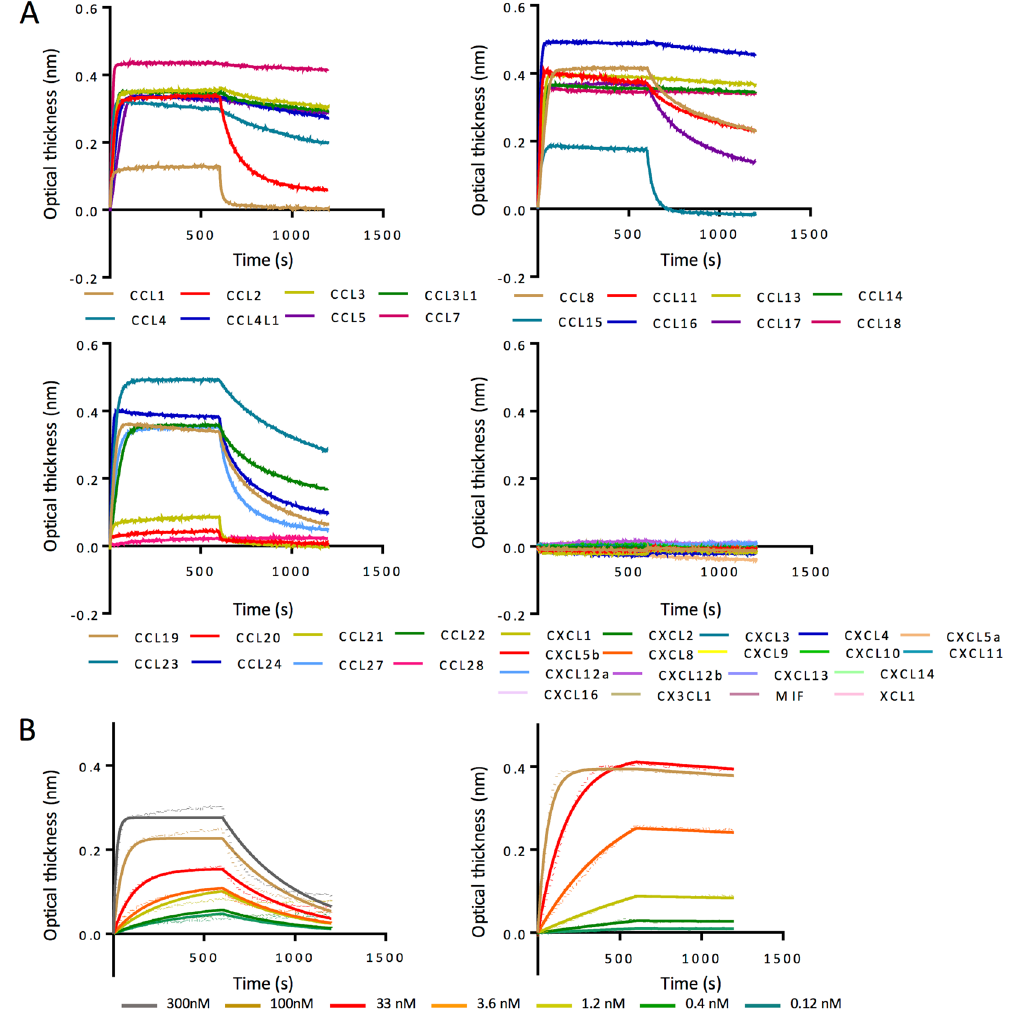
Figure 4. Characterization of P991_AMBCA by biolayer interferometry. ( A) P991_AMBCA cross binding. Biolayer interferometry sensorgrams showing P991_AMBCA binding to different chemokines at 300 nM. Plots display optical thickness (y-axis, nm) versus time (x-axis, seconds). ( B ) P991_AMBCA binding to indicated chemokines. Biolayer interferometry sensorgrams showing P991_AMBCA binding to different doses (ranging from 300 nM to 0.4 nM) of chemokines CCL2 (left panel), and CCL13 (right panel). Plots display optical thickness (y-axis, nm) versus time (x-axis,